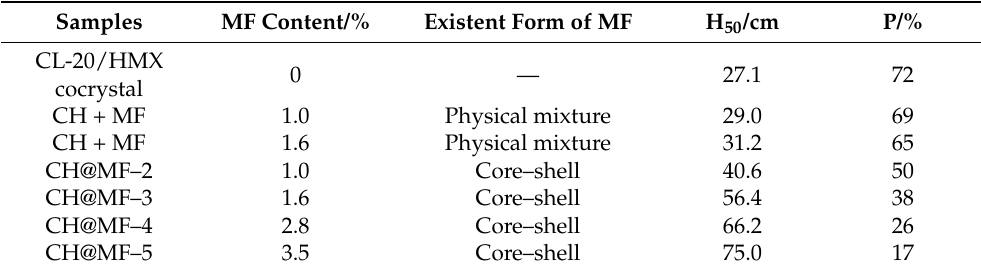
Table 5. The impact and friction sensitivity of CL-20/HMX cocrystal (CH), the mixture of CL-20/HMX cocrystal and MF resin, and CH@MF